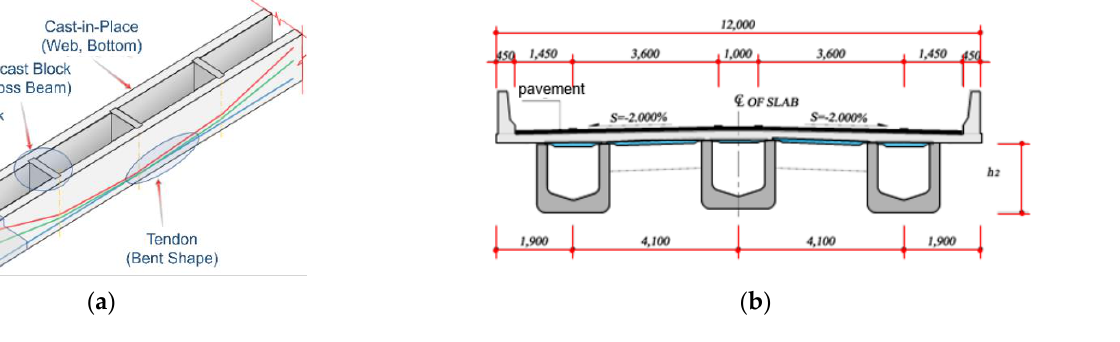
Figure 1. Configuration and conceptual diagram of the pre-tensioned U-type girder for the ( a ) unit girder (precast and cast-in-place) manufacturing method and ( b ) closed bridge section.